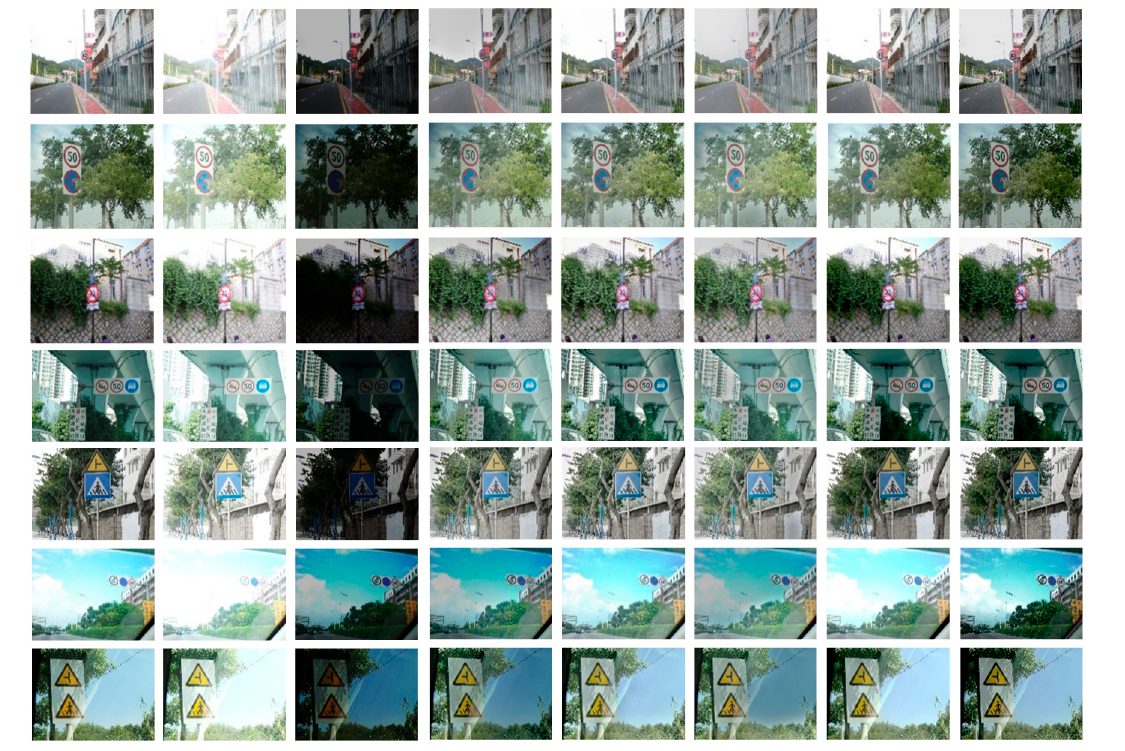
Figure 4. Qualitative comparison of our method with four methods on three typical multi-exposure image pairs in our dataset.